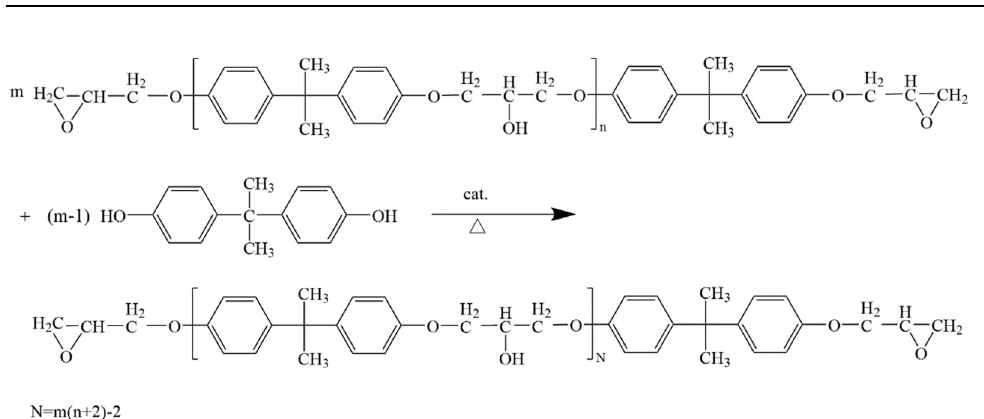
Figure 1. Schematic diagram of the synthesis of the high − molecular − weight epoxy resin. Table 1. Formulations for the preparation of emulsions.